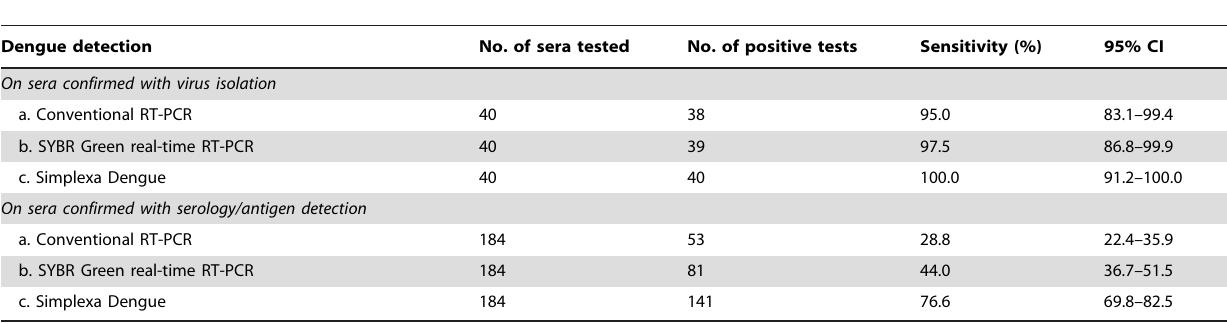
Table 1. Sensitivity of conventional RT-PCR, SYBR Green real-time RT-PCR, and Simplexa Dengue on dengue clinical samples from Indonesia.